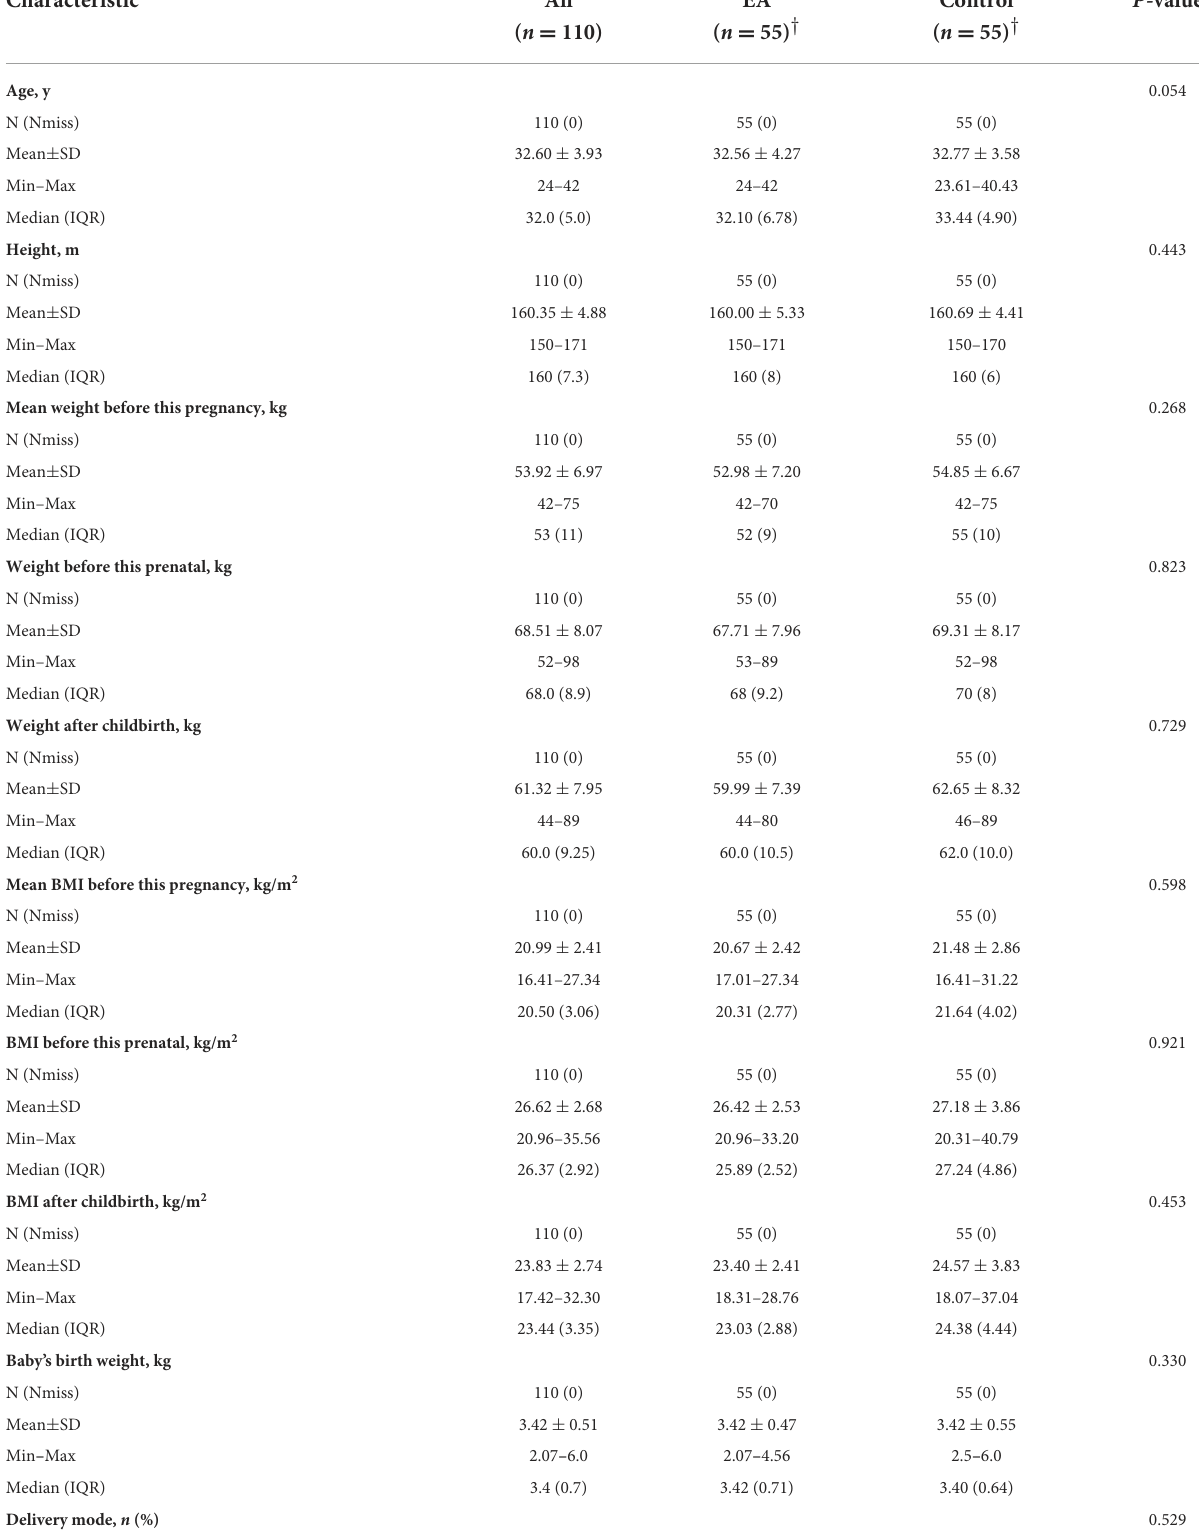
TABLE 2 Baseline characteristics of the study population *